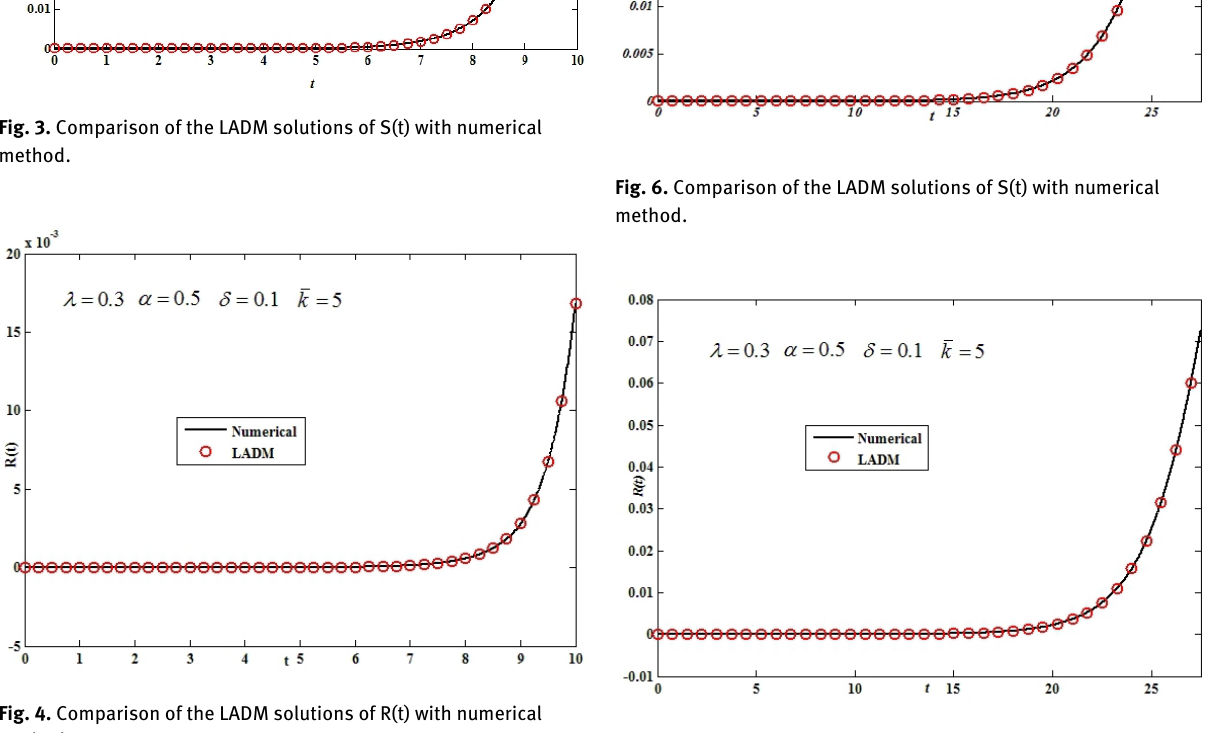
Fig. 7. Comparison of the LADM solutions of R(t) with numerical